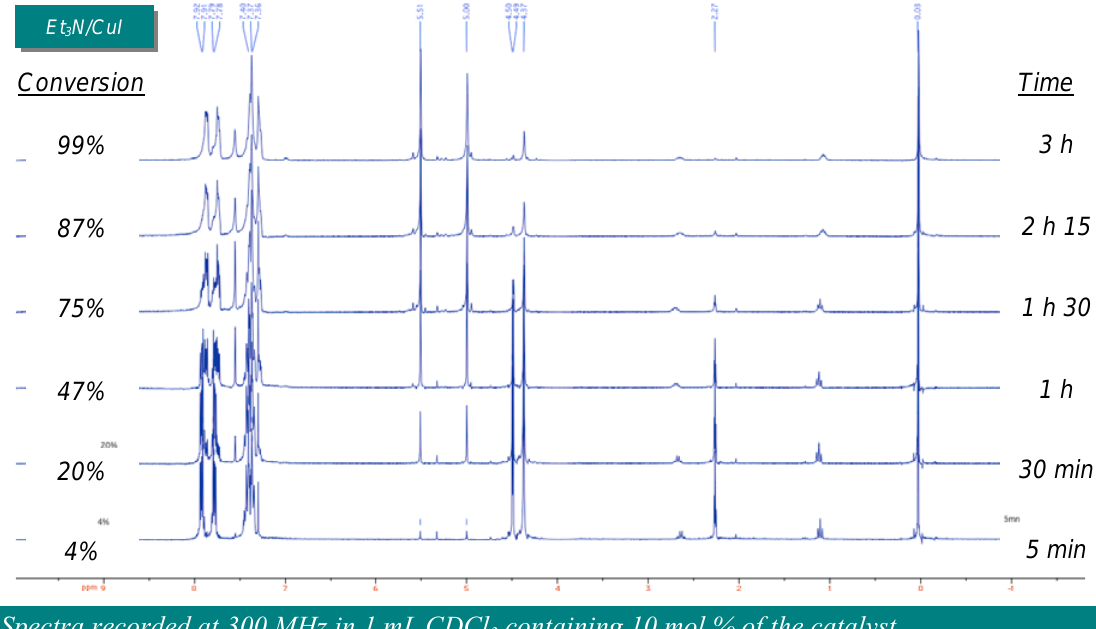
Spectra recorded at 300 MHz in 1 mL CDCl 0.5 mmol alkyne 1 and 0.55 mmol azide 2. Figure 4. NMR follow-up in heterogeneous conditions (A-21•CuI in CDCl